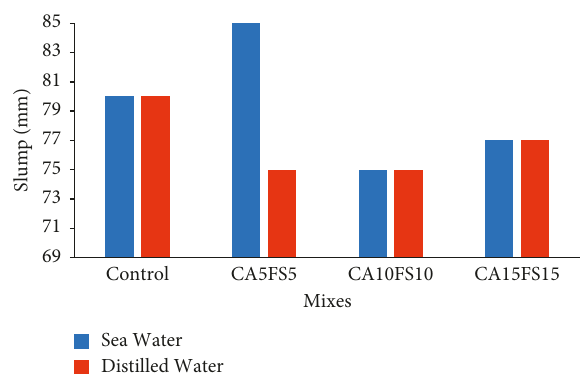
Figure 5: Slump test of CA-concrete.